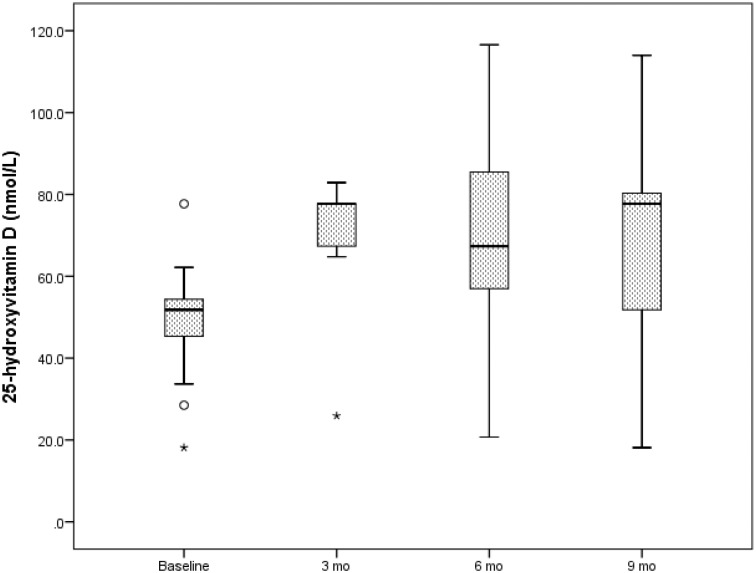
Box plot of the response of subjects with IBS to vitamin D supplementation.There was a significant rise in 25(OH)D from baseline to 3 months, 45.4 ± 14.4 nmol/L to 68.8 ± 14.4 nmol/L, p = 0.002. This increase was sustained through the 9-month observation, consistent with adequate absorption of ingested vitamin D.